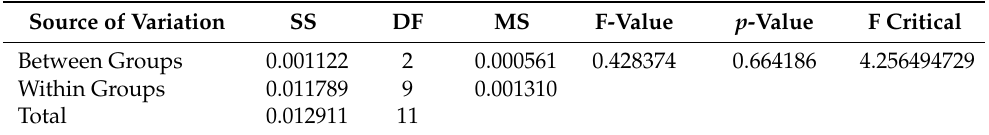
Table 7. ANOVA: Pressure Single Factor (RO).